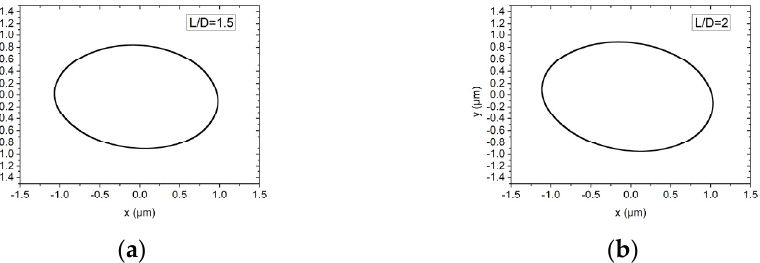
Figure 16. Rotor center trajectory under different L/D under working condition 6 (high speed, dynamic unbalance G0.1). ( a ) Rotor center trajectory ( L/D = 1.5 ), ( b ) rotor center trajectory ( L/D = 2 ).